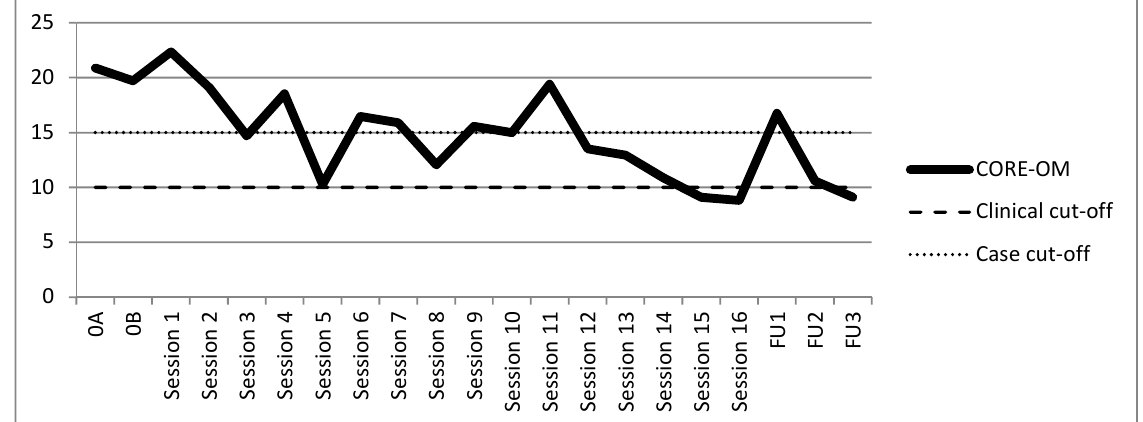
Figure 1: Sara’s weekly CORE-OM score Note. 0A and 0B = assessment sessions. CORE = Clinical Outcomes in Routine Evaluation-Outcome Measure (Evans et al., 2000). FU = follow-up.